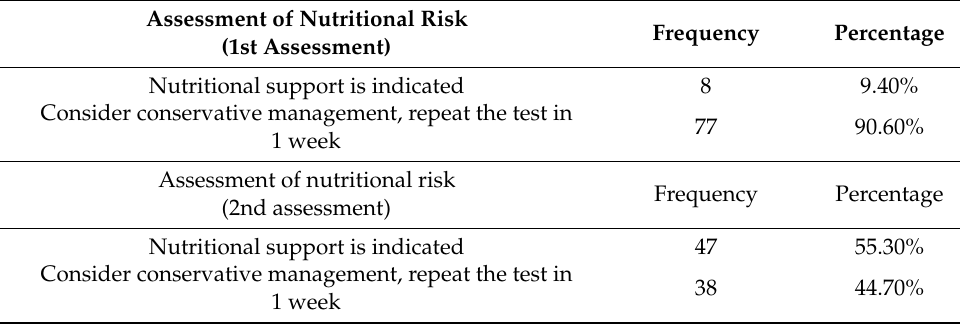
Table 7. Assessment of nutritional risk before and after radiotherapy